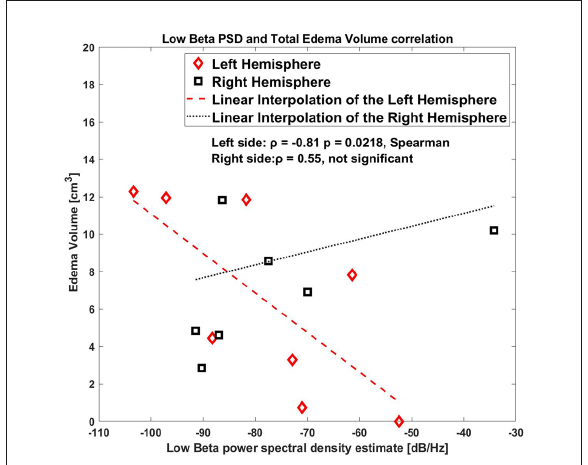
FIGURE3 Correlation between low beta band power and the edema volume for both sides, right and left hemispheres.